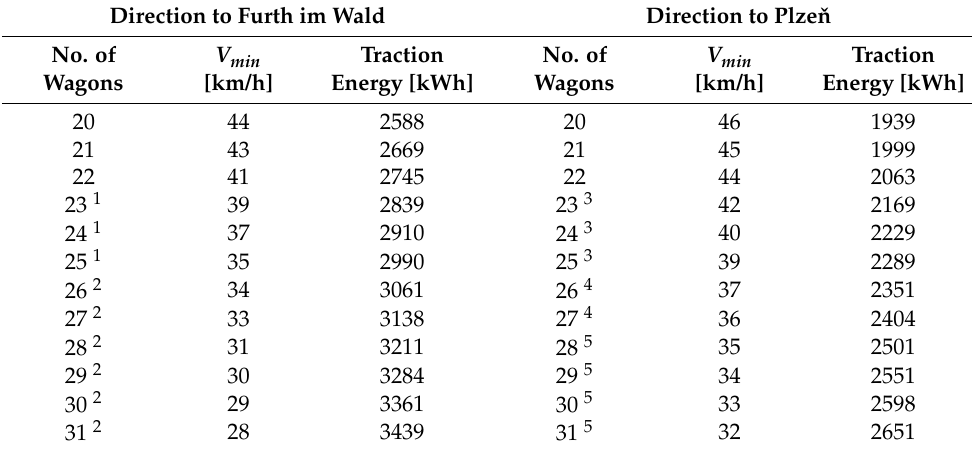
Table 10. Sensitivity analysis for the model train with Stadler locomotive on the line